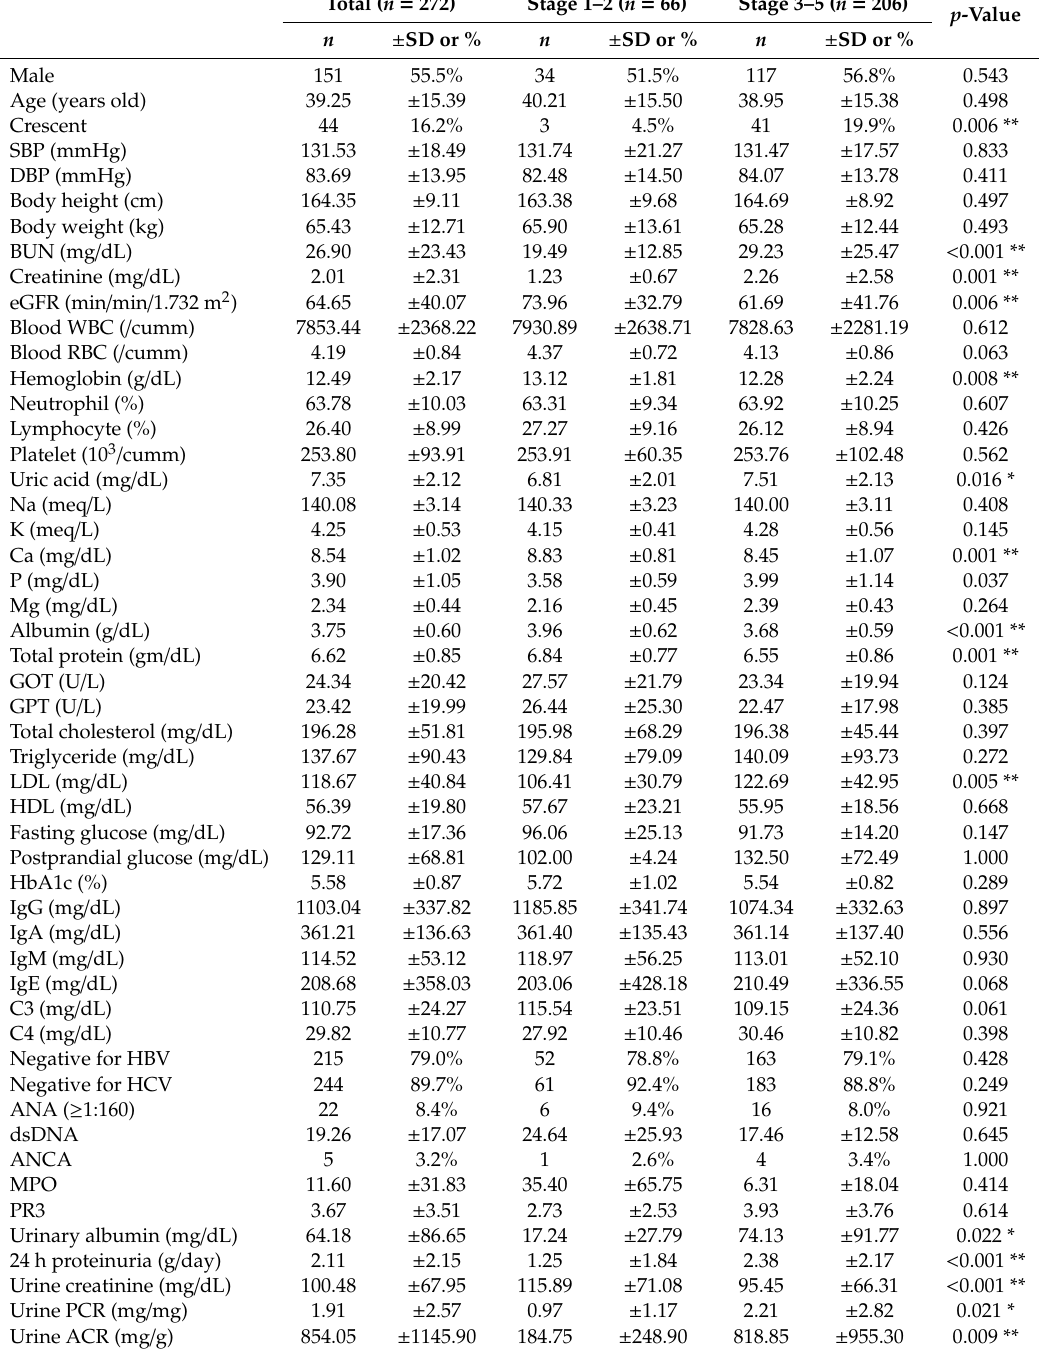
Table 1. Demographic characteristics of IgA nephropathy by Haas’